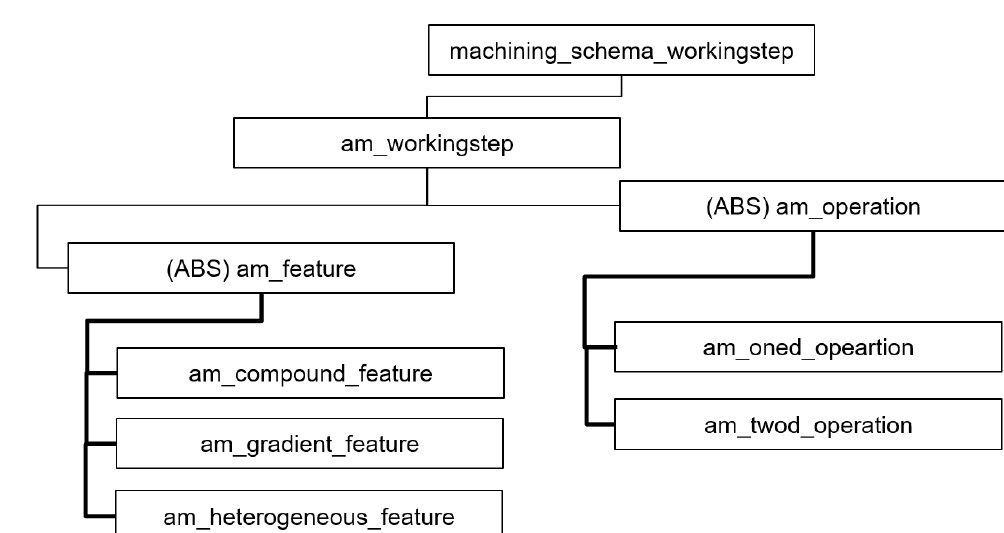
Figure 1. The high-level structure of STEP-NC additive